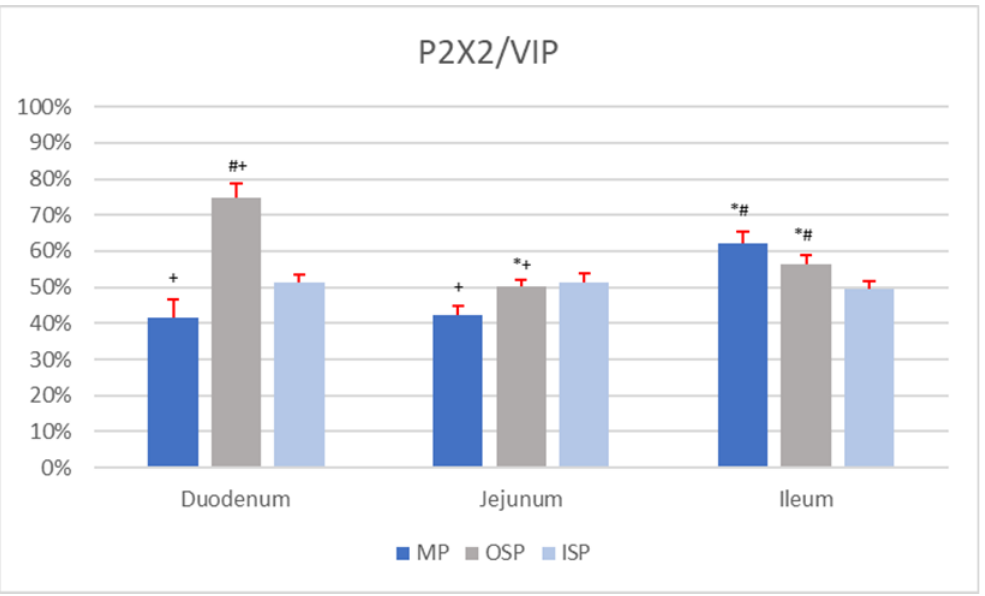
Figure 5. Percentage of P2X2-IR/VIP-IR neurons in individual nerve plexuses (MP, OSP, and ISP) of the duodenum, jejunum, and ileum. Statistically significant differences ( p < 0.05) between mean numbers of P2X2-IR/VIP-IR neurons in analogous nerve plexuses of different sections of the small intestine were marked: * vs. duodenum, # vs. jejunum, + vs. ileum.